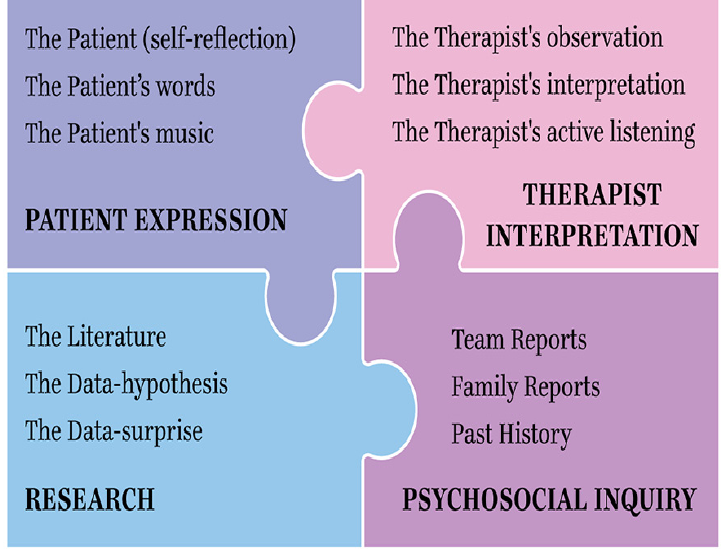
Figure 1. Pain Assessment Quadrant: an integrative model.